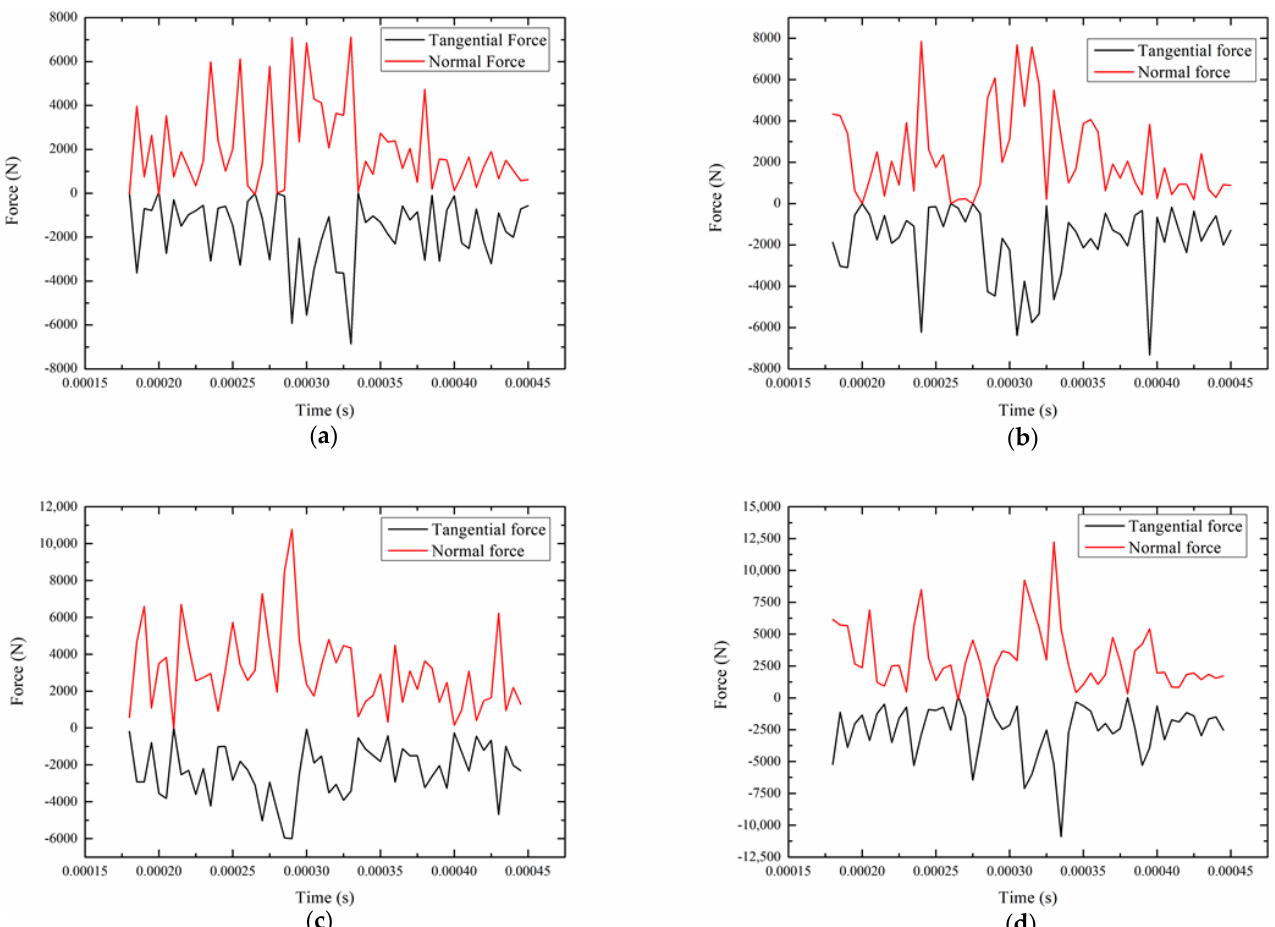
Figure 9. Normal force and tangential force values under different viscosities ( a ) 10 Pa·s viscosity, ( b ) 20 Pa·s viscosity, ( c ) 30 Pa·s viscosity, ( d ) 40 Pa·s viscosity.